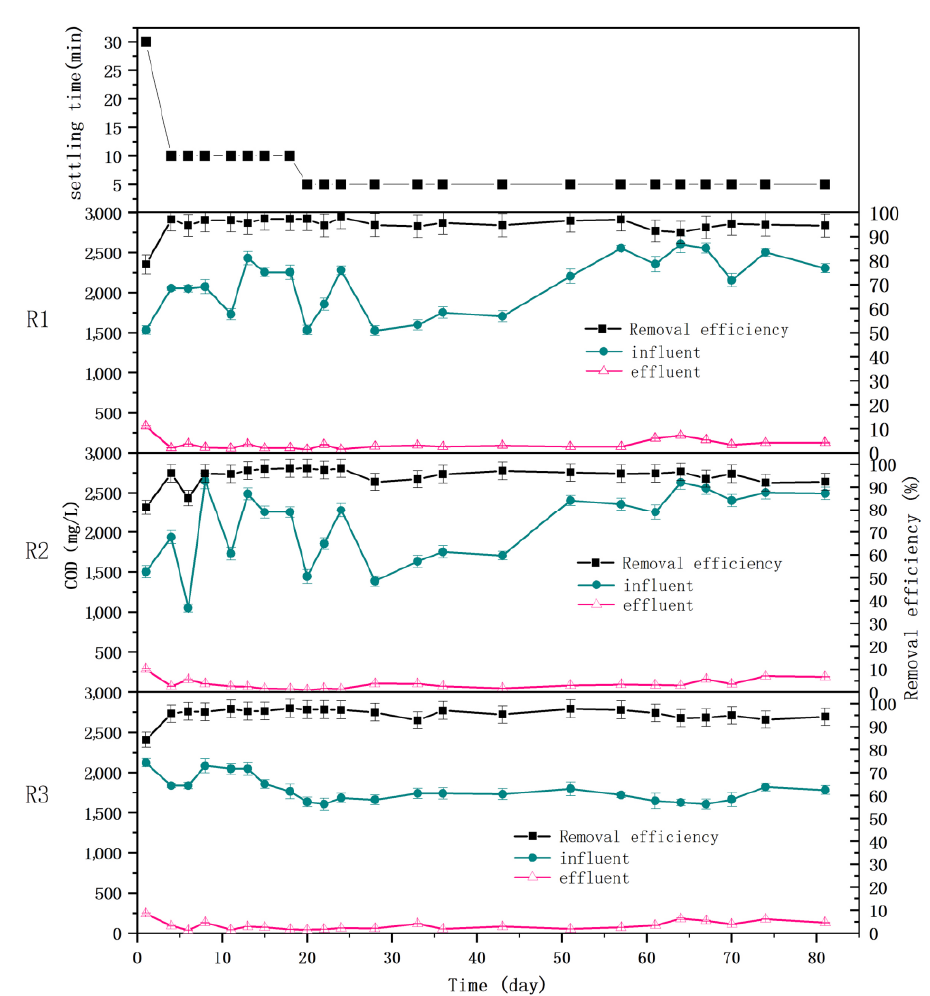
Figure 1. The pollution degradation during aerobic granules’ formation processes in R1, R2, and R3.